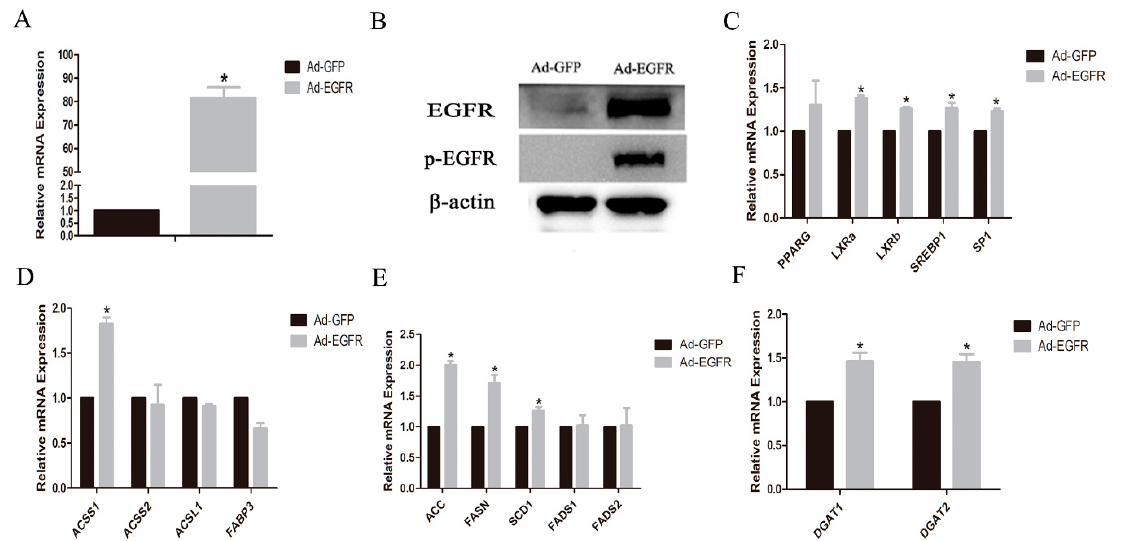
Figure 3. Effect of EGFR overexpression on genes related to lipid metabolism in GMECs. ( A , B ) EGFR mRNA and protein levels in EGFR-overexpressed GMECs were analyzed, using RT-PCR. Effect of EGFR overexpression on the mRNA expression levels of transcription factors ( C ), de novo fatty acid synthesis and desaturation ( E ), fatty acid uptake and activation ( D ) and TG synthesis ( F ). Ad-GFP is negative control. Values are presented as means ± SD of three independent experiments. * Means p < 0.05.